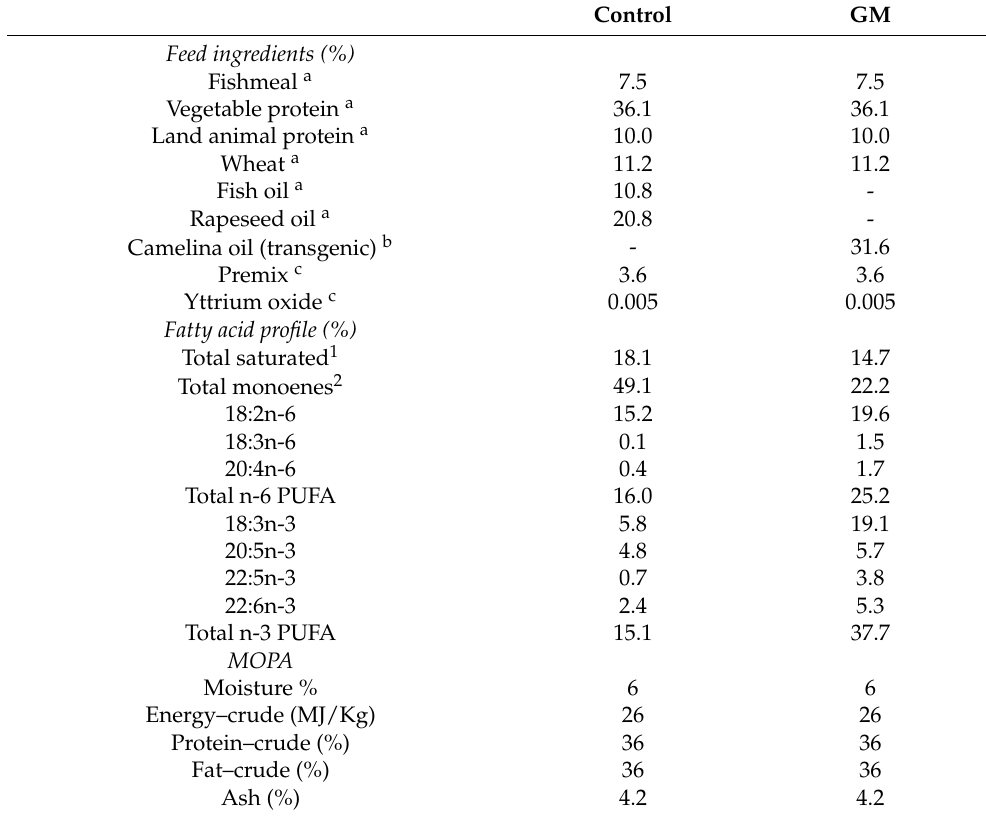
Table 1. Diet formulation and fatty acid composition of the control and GM diets. The provenances of the ingredients used were a Biomar AS, Brande, Denmark, b Rothamsted Research, Harpenden, UK, c DSM, Basel,